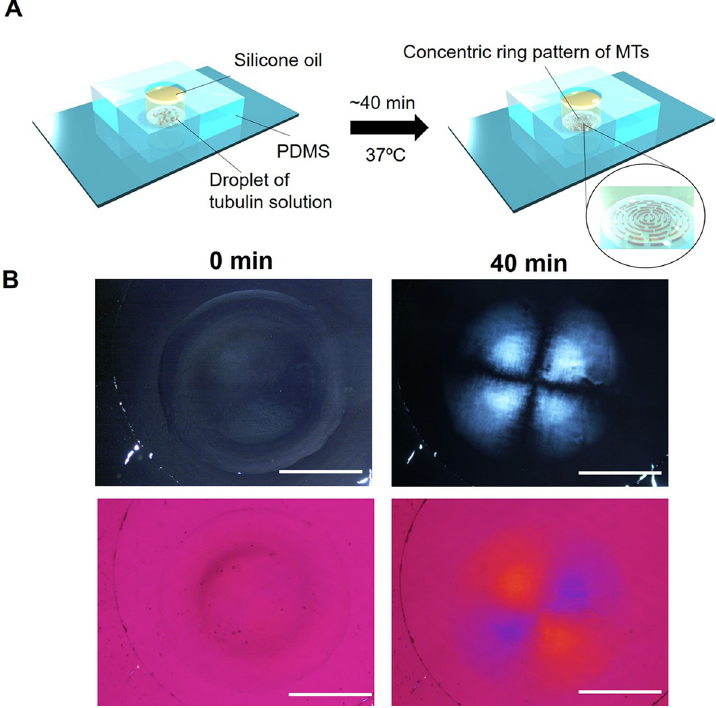
Fig 3. Formation of concentric ring like pattern of MTs by modulating of evaporation of water. (A) Schematic presentation of the experimental design of inhibition of water evaporation from a droplet of tubulin solution. The droplet was placed on a glass surface enclosed in polydimethylsiloxane (PDMS) sheet and sealed by silicone oil. (B) Polarized optical microscopy images of droplet of tubulin solution sealed with silicone oil as shown in the schematic presentation. At 0 min no birefringence and color change were observed under retardation plate. After 40 min of evaporation at 37 o C, birefringence was observed and color change under retardation plate indicates polymerization of MTs took place which formed a concentric ring like pattern. The volume of tubulin solution was used 2 μ L for placing the droplet and concentration was 180 μ M. Scale bar: 1 mm.